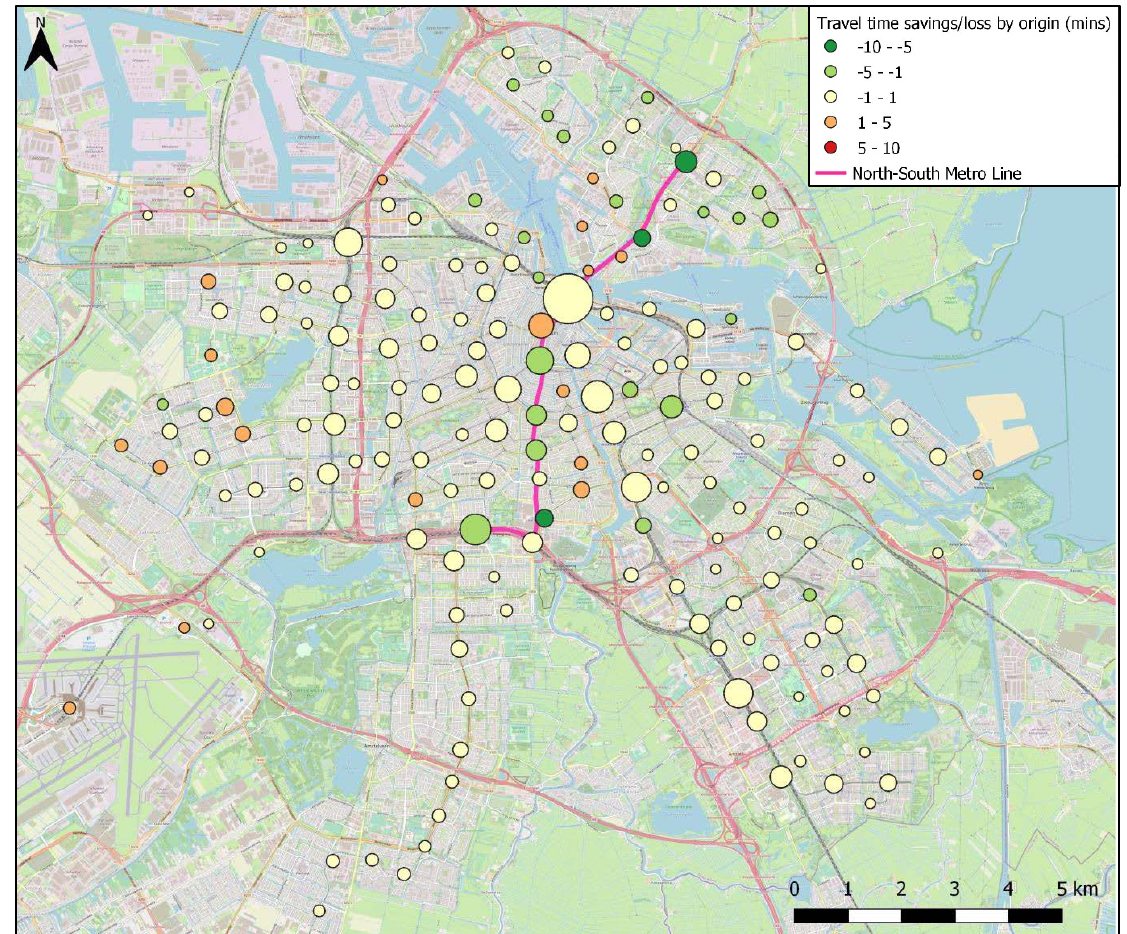
Figure 9. Geographical distribution of travel time changes by origin stop cluster (weekday 7am to 7pm) (Base map and data from OpenStreetMap and OpenStreetMap